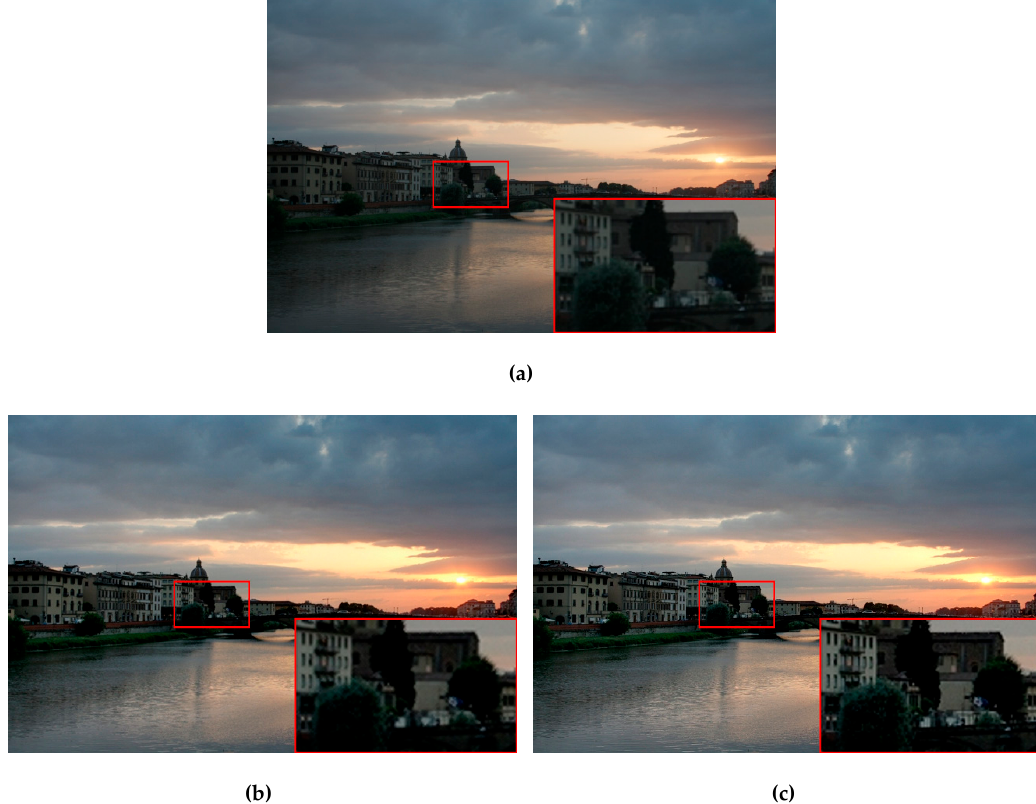
Figure 9. Illustration of the effectiveness of the proposed enhanced multiscale fusion using the test image Arno River. ( a ) Fusion result where the boosting coefficient equaled one. ( b ) Fusion result where the boosting coefficient equaled five. ( c ) Fusion result where the boosting coefficient equaled ten.